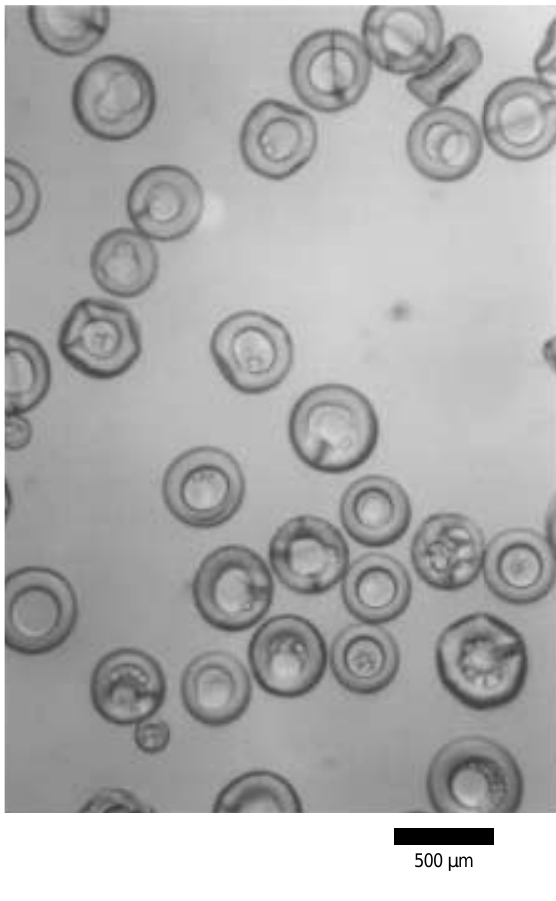
Silica Particles Produced in Discharge Mode Experimental conditions were the same as those in Fig.